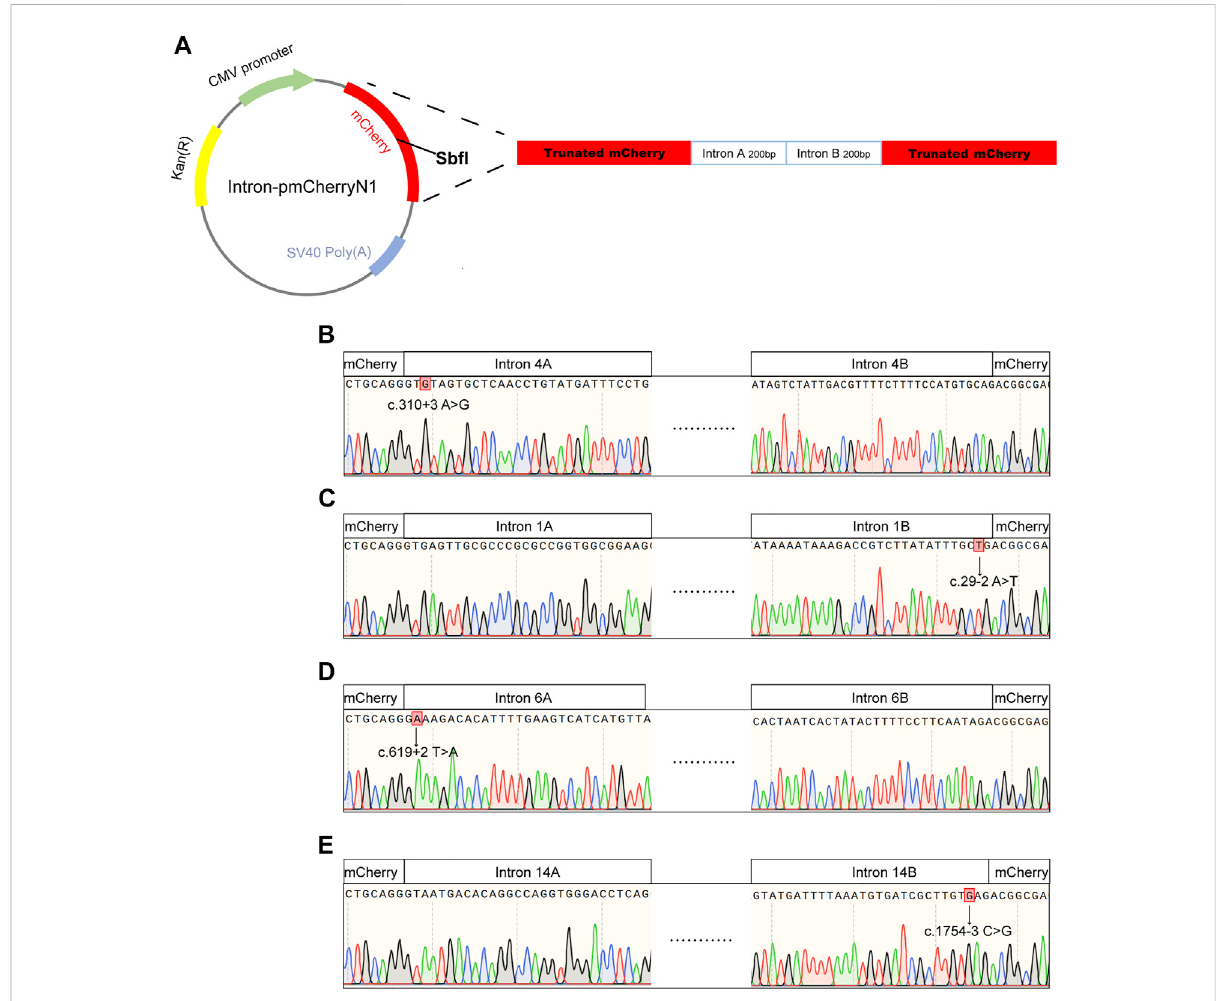
FIGURE 5 Sequences used for in vitro RNA splicing assays. (A) Schematic view of the pmCherryN1 plasmid used in the splicing assays; a shortened RPGR intron was generated for use in the assay by selecting the DNA sequence around the splice acceptor site (intron A), which was combined with the DNAsequencearoundthesplicedonorsite(intronB).Sangersequencingindicatedthatintron4Acontainedthec.c.310+3A > Gvariant (B) ,intron1B contained the c.29-2A > T variant (C) , intron 6A contained the c.619 + 2T > A variant (D) , and intron 14B contained the c.1754-3C > G variant (E)